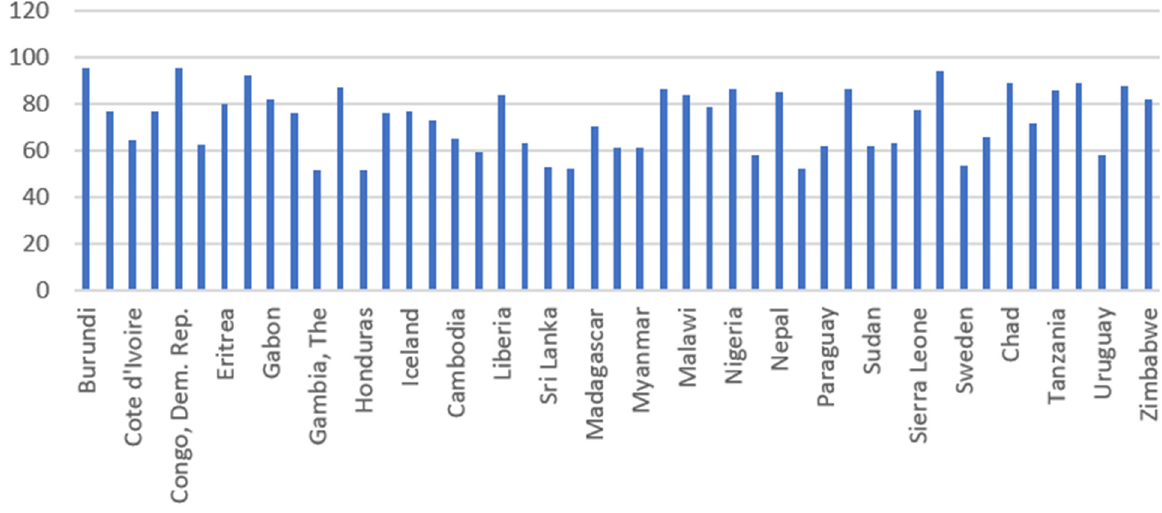
Figure 1. Renewable energy consumption for the year 2015. Notes: due to the lack of complete data, Eritrea, Liechtenstein, Papua New Guinea, and Somalia are not included in the empirical analysis.